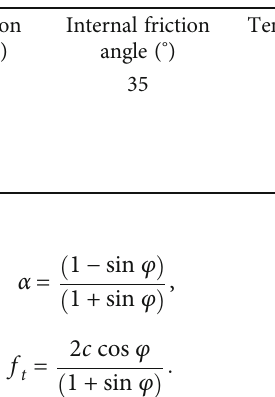
Table 1: Mechanical parameters of optimized rock